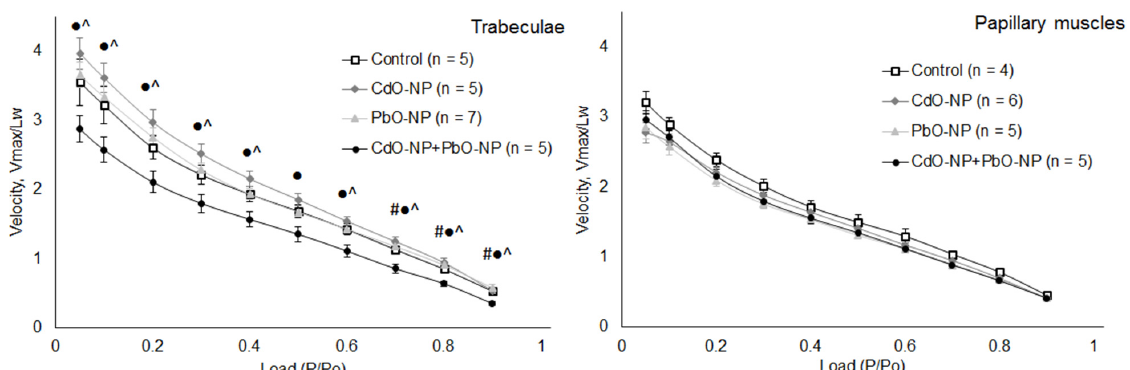
Figure 5. The force–velocity relationships of isolated trabeculae (left panel) and papillary muscles (right panel). Velocity is shown in relative units according to muscle’s working length. Data are shown as mean ± s.e. There are significant differences: #—CdO–NP + PbO–NP vs. Control, ^—CdO–NP + PbO–NP vs. PbO–NP, ● —CdO–NP + PbO–NP vs. CdO–NP ( p < 0.05). Table 3. The velocities of regulated thin filament sliding movement over rat ventricular myosin in all experimental groups (X ± s.e.).